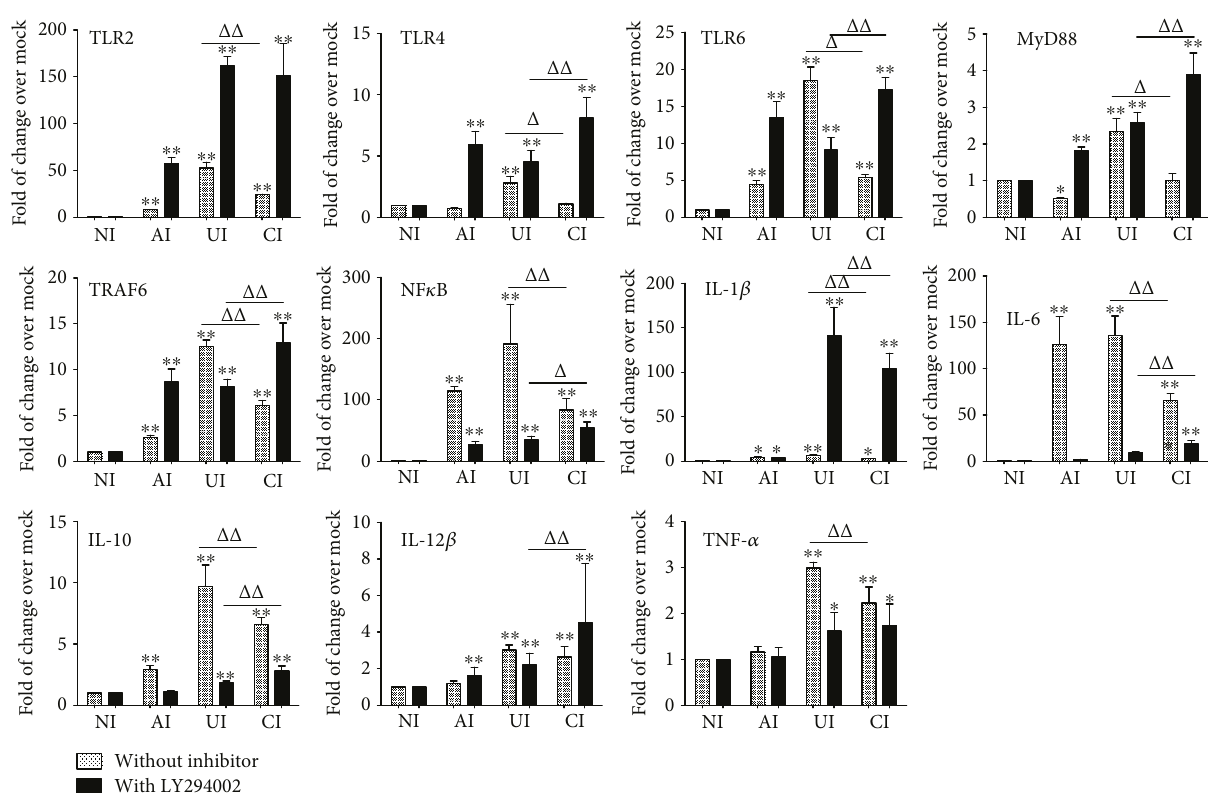
Figure 5: Impact of PI3K signaling in U937 cells in response to H37Rv infection. In the presence or absence of PI3K inhibitor LY294002,